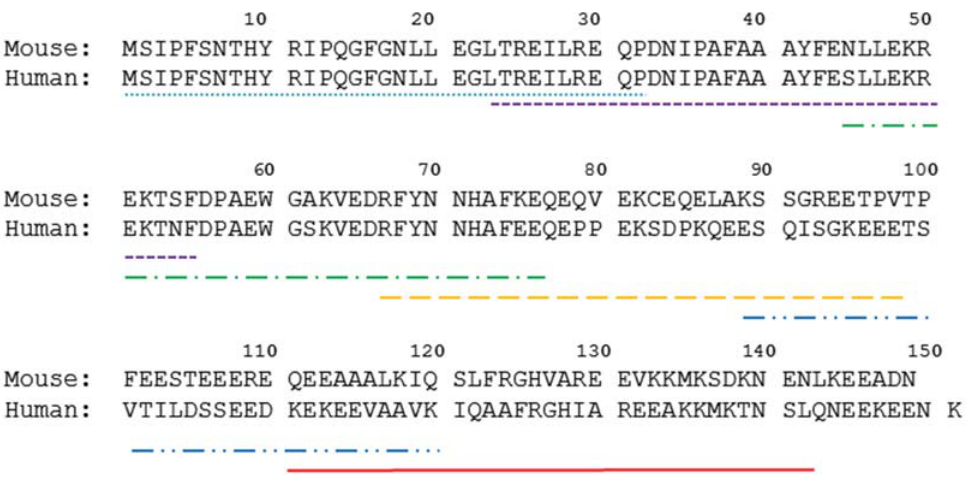
Figure 1. Diagram of both human and mouse Sp17 amino acid sequences (adapted